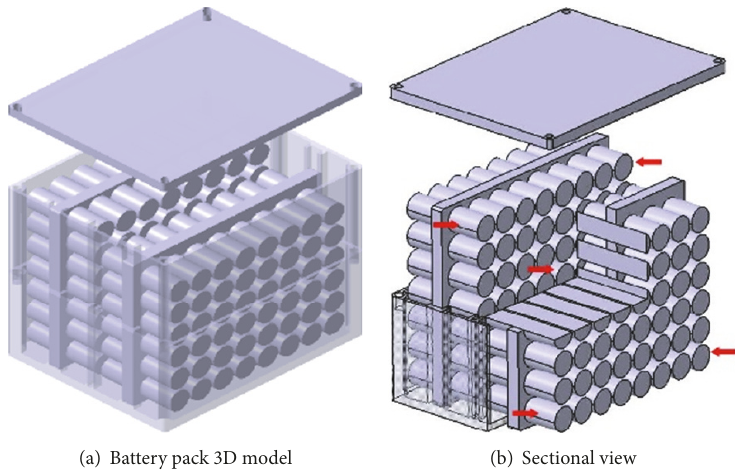
Figure 4: Positions of the temperature sensors in the battery pack.